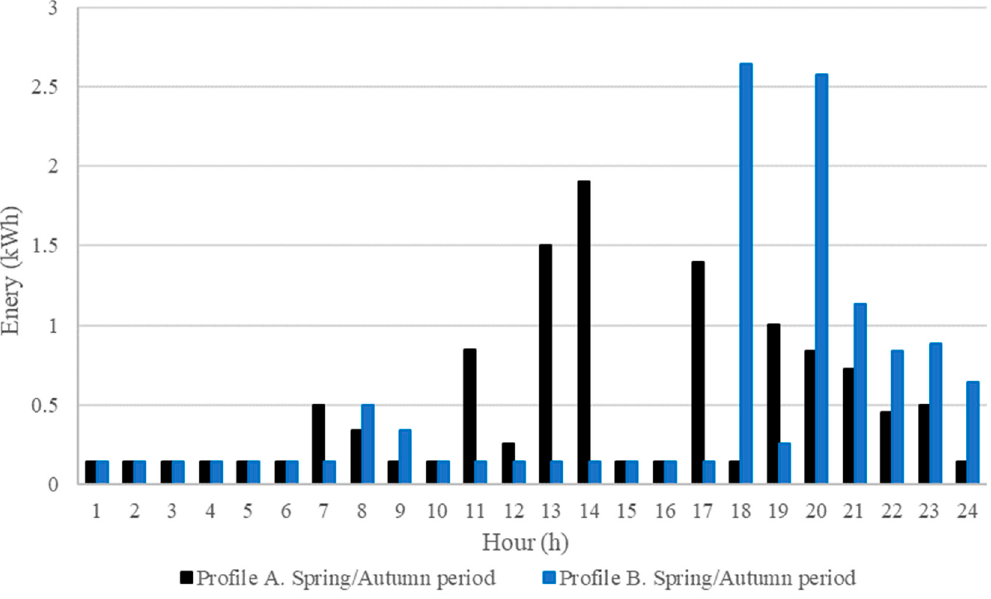
Figure 10. Hourly electricity consumption (appliances and lighting) in households during spring and autumn days.